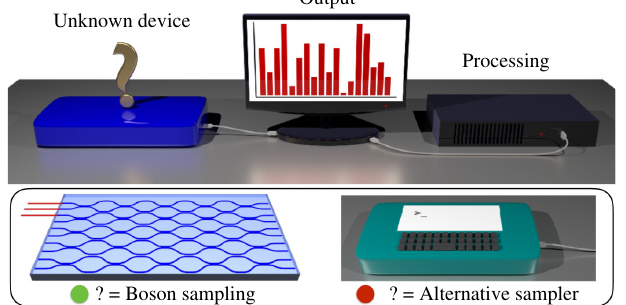
FIG. 1. Validation of boson-sampling experiments. An agent has to discriminate whether a finite sample obtained from an unknown device has been generated by a quantum device implementing the boson-sampling problem or by an alternative